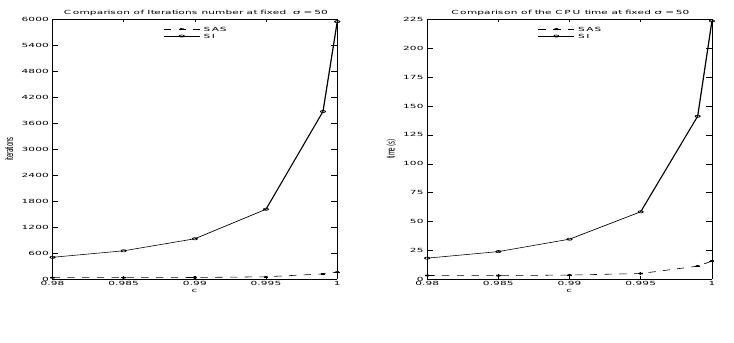
Figure 6. Comparison of the SI and SAS methods in 2D case at fixed σ = 50 , for c ≈ 1 ( ǫ = 1 E − 05 ): (left) number of iterations; (right) CPU time.